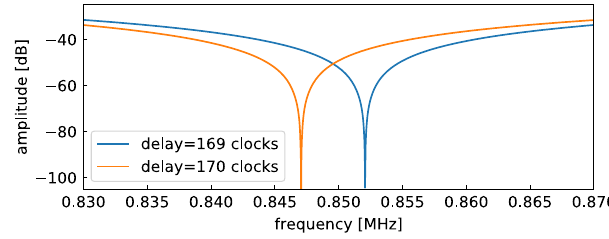
FIG. 10. Amplitude response of the tracking CIC filter for ¼ 850 kHz, with a delay of 169 and 170 clocks. f rev